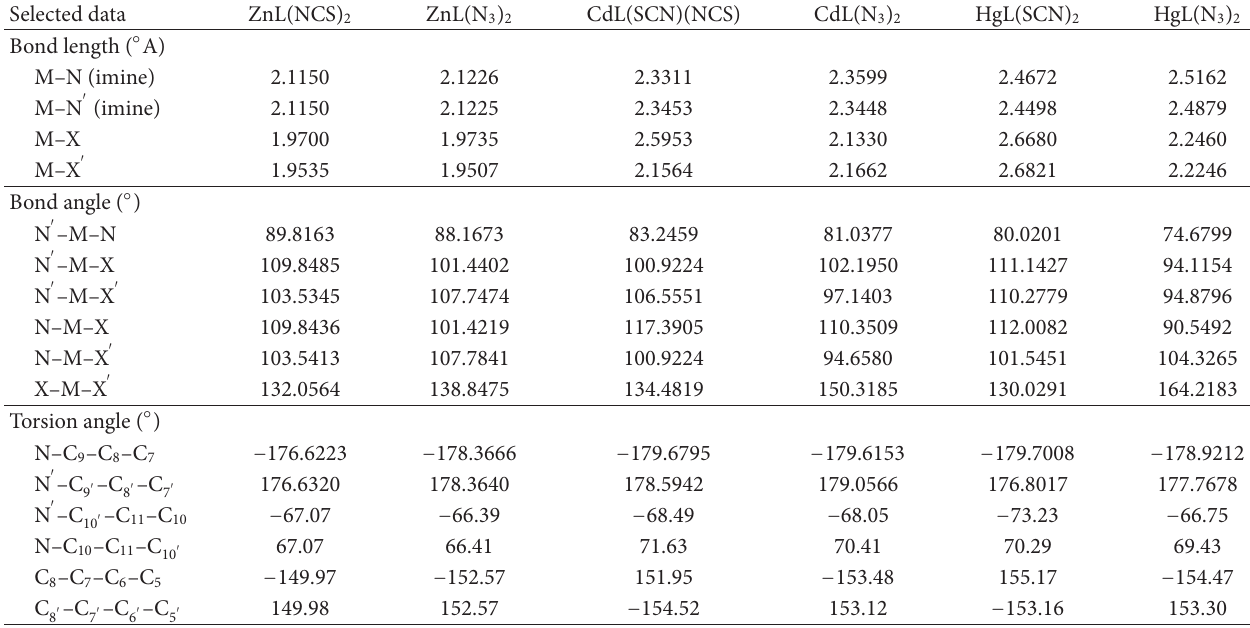
F 3: Optimized structure of ligand (a), ZnL(N T 2: Some selected structural data derived from theoretical